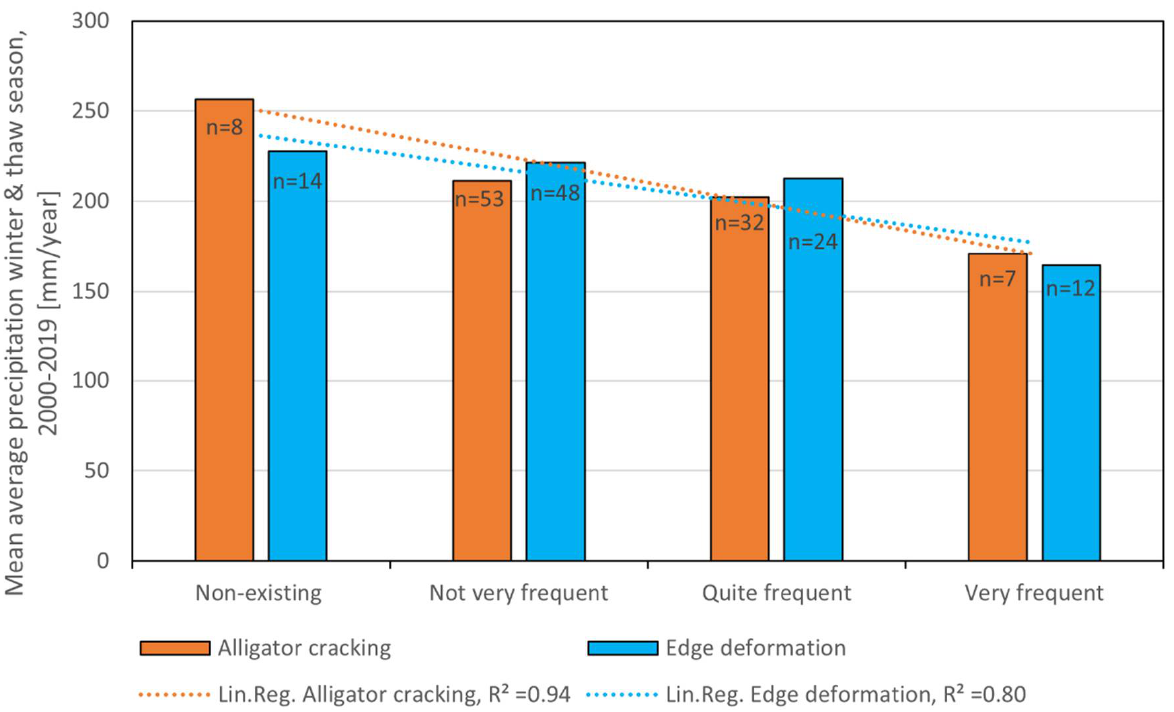
Figure 5. The correlation of the stated frequency of alligator cracking and edge deformation on municipal cycle paths and the mean average precipitation for winter and thaw seasons 2000–2019.